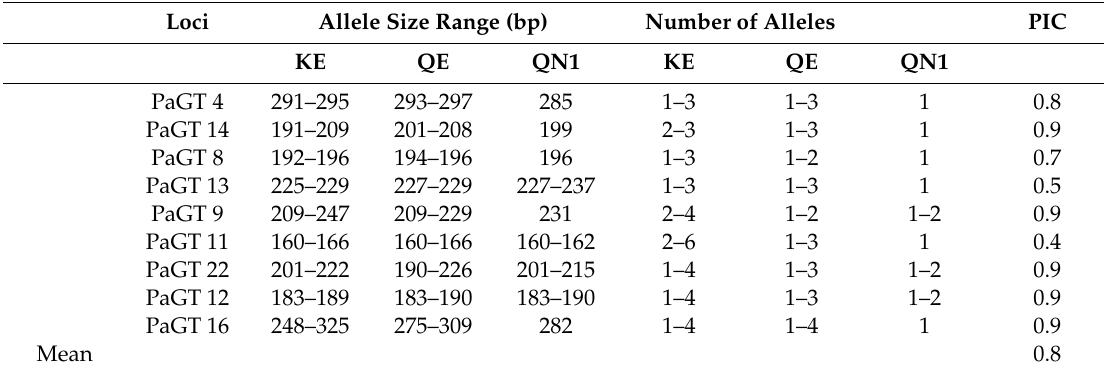
Table 4. Microsatellite loci and allelic diversity measures in invasive and native Phragmites australis populations from Quebec, Canada and Kashmir, India.